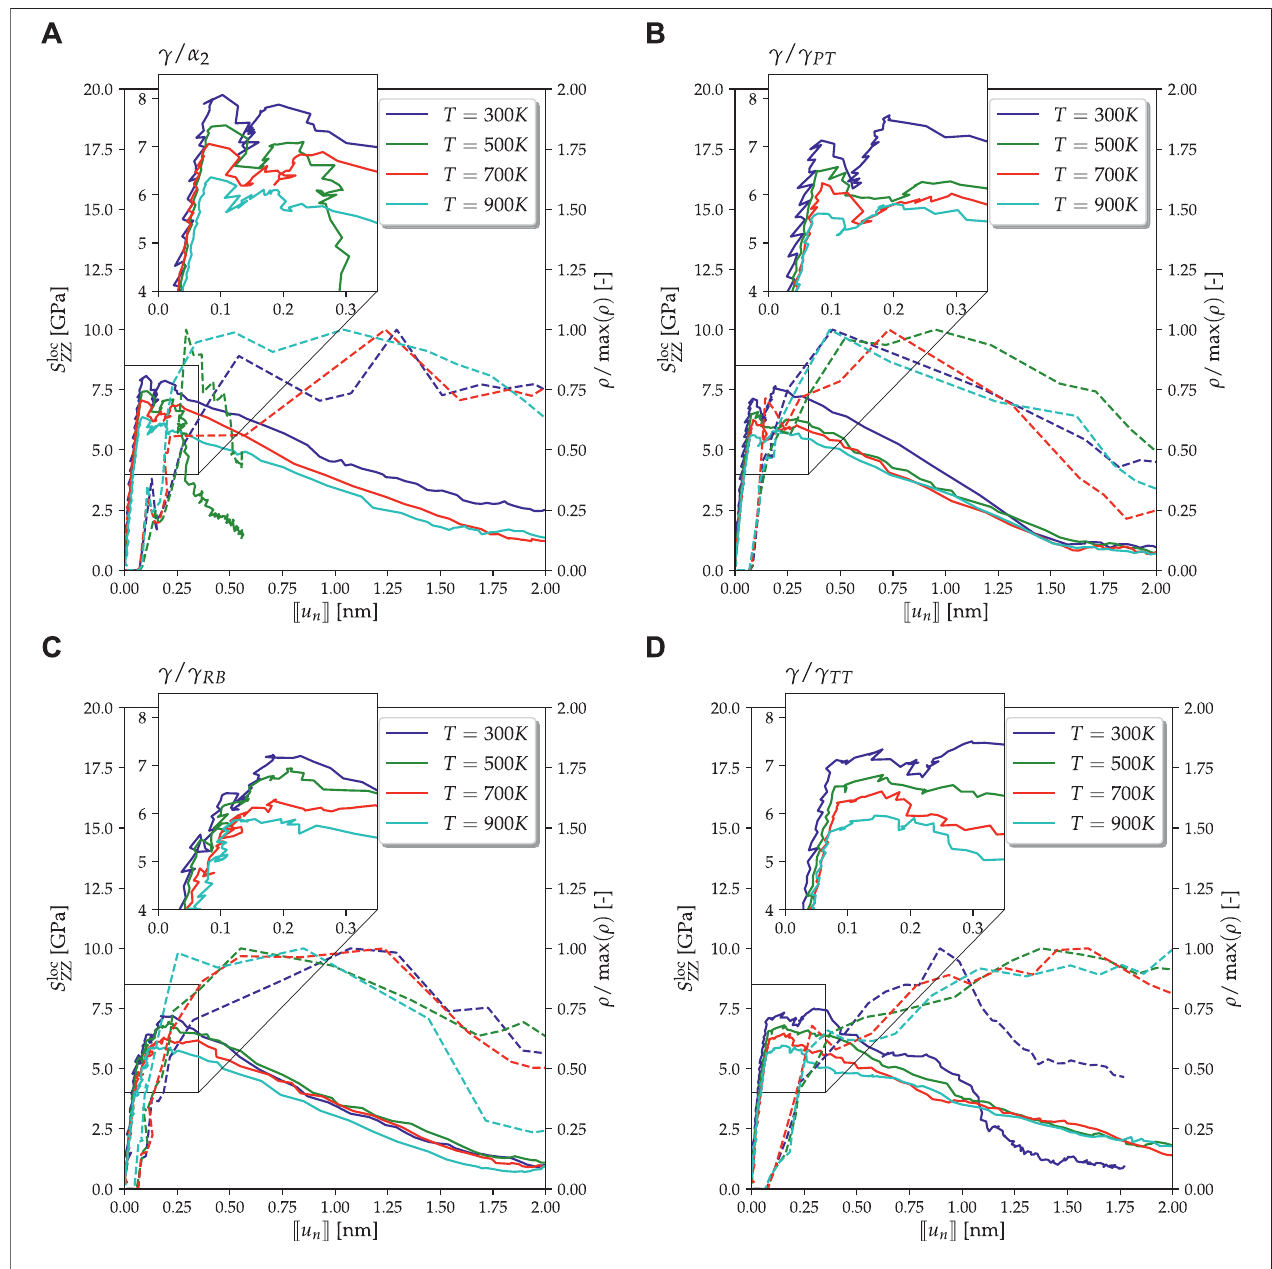
FIGURE8| Traction-separationcurves(solidlines)fromMDsimulationswithstrainrate T (cid:2) 900Kandstrainrate _ ε glo ZZ (cid:2) 10 9 / s fordifferenttemperaturesandType-2 models ofdifferentinterfaces(i.e., (A) c / α 2 , (B) c / c PT ,and (C) c / c RB , (D) c / c TT ).Theevolutionofthe dislocation density isillustratedbythedashed lines.Theinset fi gures show the traction-separation curves in the yielding regime in greater detail.